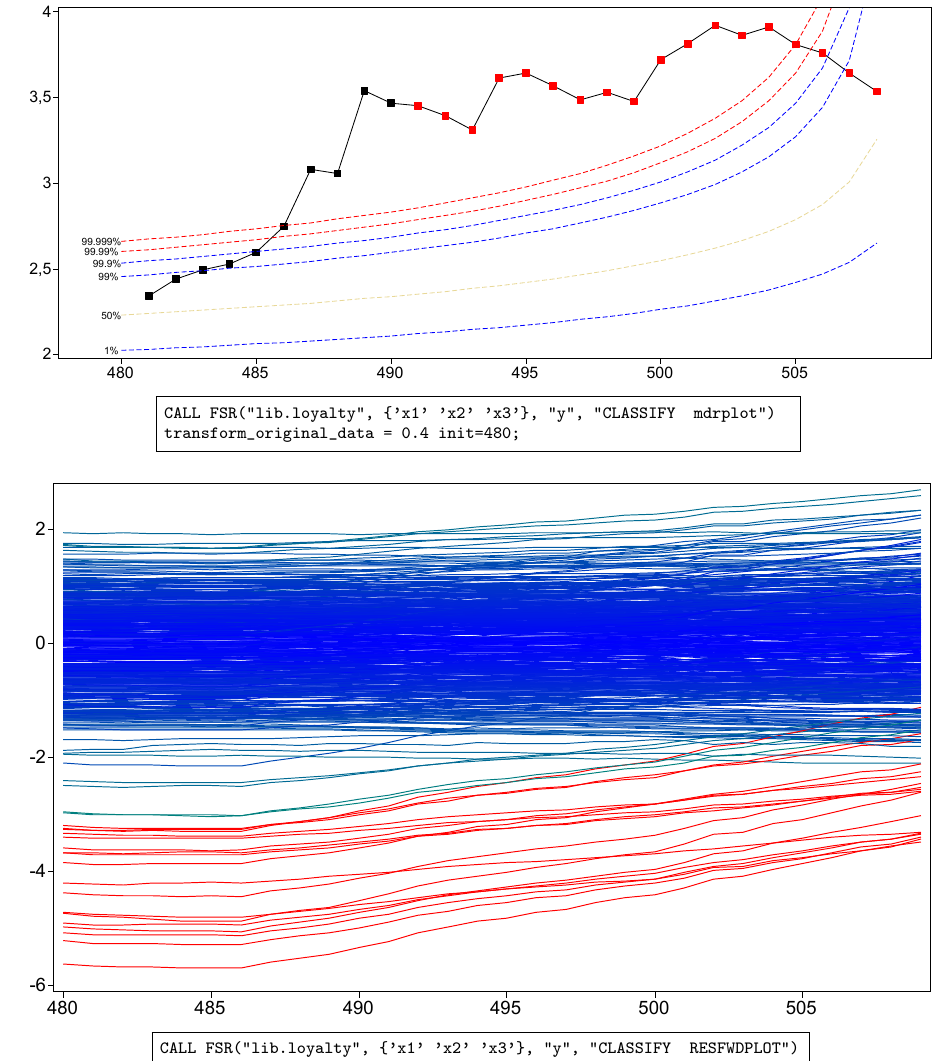
Figure 3. Loyalty card data with λ = 0.4: zoom of Figure 2 monitoring the last 30 observations. Absolute values of minimum deletion residuals among observations not in the subset and envelopes for the full 509 observations. Lower panel: scaled residuals, with the trajectories corresponding to the 18 detected outliers in red.